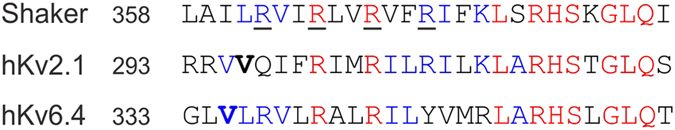
Sequence alignment of the Shaker, KV2.1 and KV6.4 S4 region.The underlined arginine residues in Shaker represent those that contribute to the gating charge. The bold valine residues were substituted for cysteines in KV2.1 (KV2.1(V296C)) and KV6.4 (KV6.4(V335C)). In red are shown residues that are conserved among the three channel sequences, while blue residues represent those conserved in only two sequences. The remaining ones are shown in black.